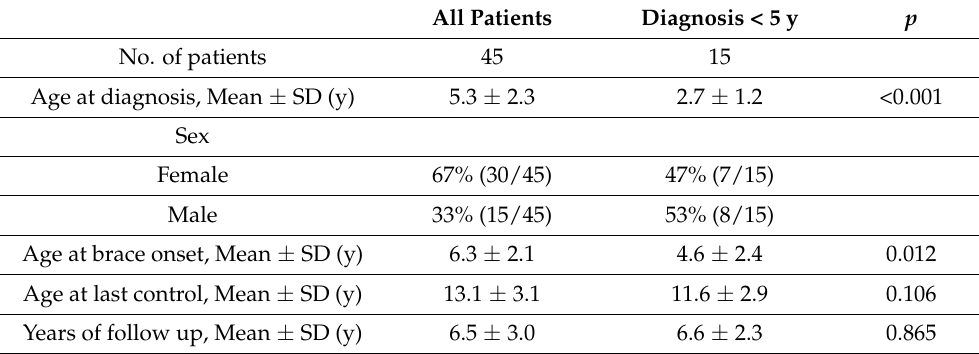
Table 2. Baseline characteristics of study population (significance p <